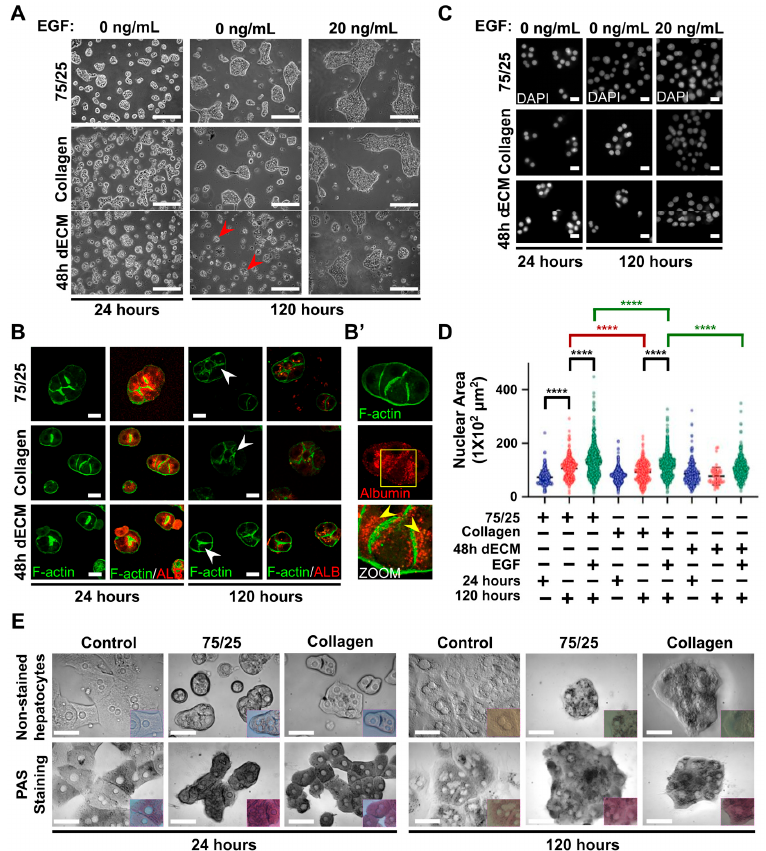
Figure 4. Cortical actin filaments and actin proximal to canaliculi-like structures are preserved in primary hepatocytes cultured on soft PAA HGs in long cultures, but albumin protein expression is lost. ( A ) Representative DIC images of hepatocytes cultured on soft PAA HGs linked di ff erent ECM at 24 h and 120 h of culture in the absence or presence of (20 ng / mL) EGF after 24 and 120 h of culture. Apoptotic bodies: red arrowheads. Images were obtained from a 20 × objective. Scale bar: 200 µ m. ( B ) Representative immunofluorescence confocal microscopy images of albumin protein and F-actin in hepatocytes cultured on 1 kPa PAA HGs conjugated with di ff erent ECMs at 24 h and 120 h of culture. Canaliculi-like ducts: white arrowheads. Images were obtained from a 63 × objective. Scale bar: 20 µ m. ( B’ ) 3D projection from confocal microscopy images of F-actin and albumin protein in primary hepatocytes cultured on soft PAA HGs at 24 h of culture. The localization of albumin protein is highlighted in yellow squares. Albumin protein distribution: yellow arrowheads. ( C ) Representative epifluorescence images of nuclei (DAPI) of hepatocytes cultured on soft substrates conjugated di ff erent ECM after 24 h and 120 h of culture in the absence or presence of (20 ng / mL) EGF. Images were obtained from a 63 × objective. Scale bar: 20 µ m. ( D ) Quantification of nuclear areas of hepatocytes cultured on conditions depicted in (C). Data are represented as mean ± SD of a representative of 2 independent experiments, **** p < 0.0001. ( E ) Periodic acid-Schi ff (PAS) staining detection showed that glycogen storage is abundantly conserved in primary hepatocytes cultured on soft PAA hydrogels compared with those cultured on standard polystyrene plates with deposited collagen. Upper panels: show non-staining hepatocytes cultured for 24 through 120 h. Lower panels: Cytoplasm with darker gray shades indicates higher glycogen storage levels. Inner panels show color images of both stained and non-stained hepatocytes. Purple-magenta color indicates positive cells to glycogen. Representative images were collected from each of three independent experiments per treatment condition. ECM mixtures: collagen, 100% collagen type I; 75 / 25, 75% collagen type I plus 25% BM; 48 h dECM: ECM after 48 h of digestion. Scale bars; 50 µ